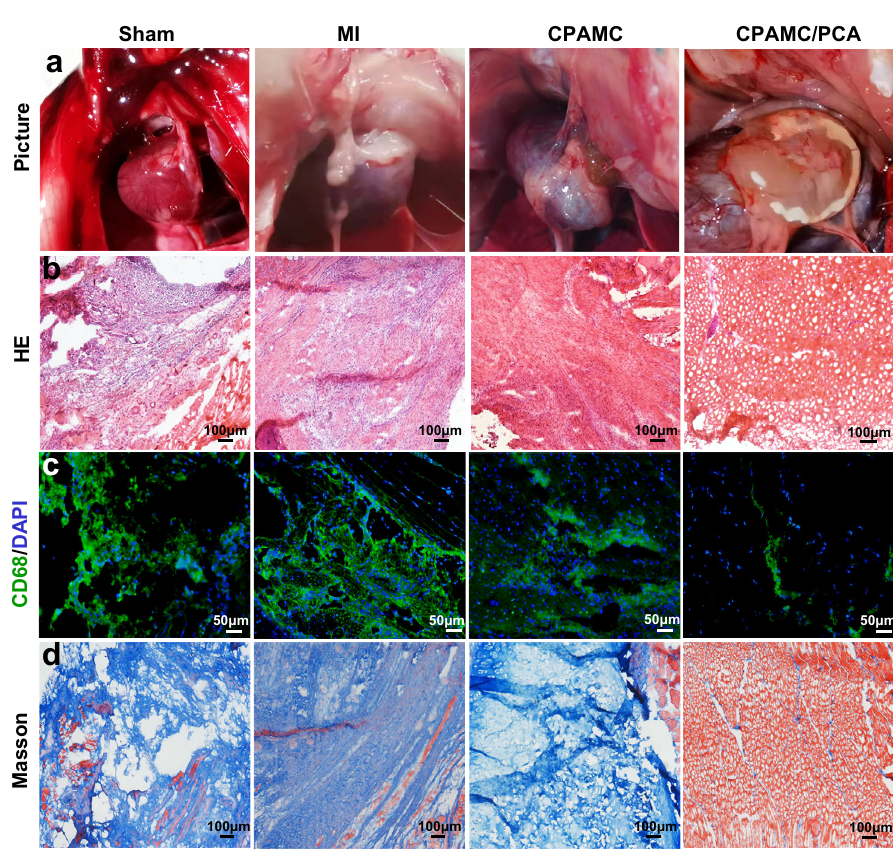
Fig. 8 | Evaluation of anti-adhesion function of CPAMC/PCA hydrogel in MI rat model. a Representation of heart adhesion to chest wall. b , c HE staining and immuno fl uorescence were used to evaluate the in fl ammatory status of chest wall tissue. d The fi brosis was assessed by Masson trichrome staining the chest wall